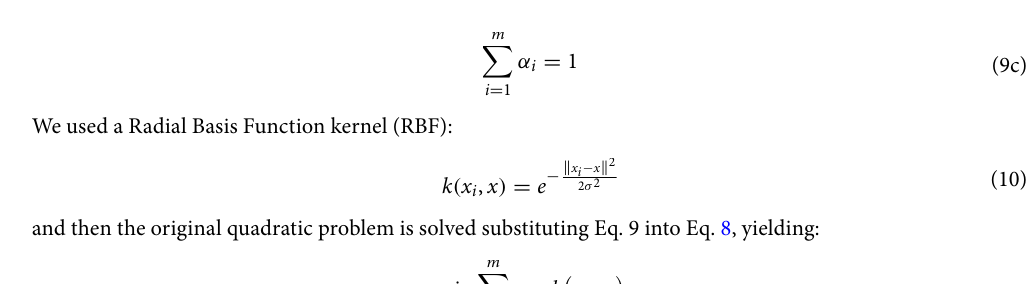
Figure 8. Schematic representation of DEC detector